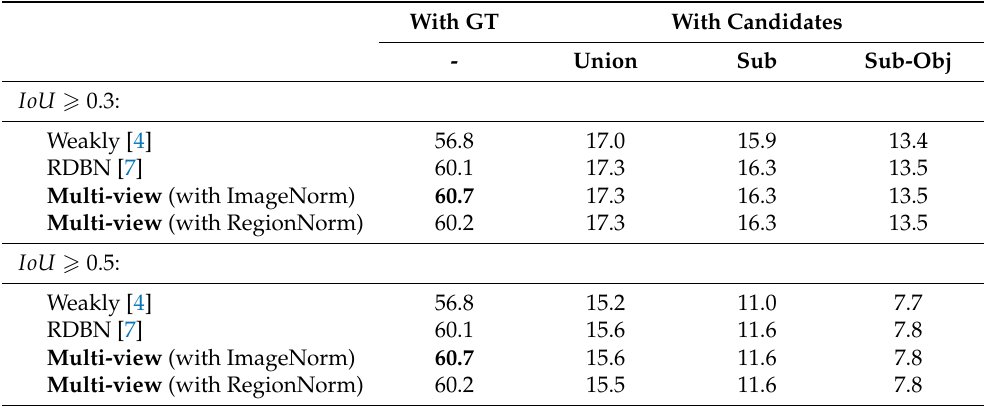
Table 3. Image retrieval performance (% mAP) of different VRD frameworks on UnRel dataset [4]. The IoU threshold is higher, the retrieval task is